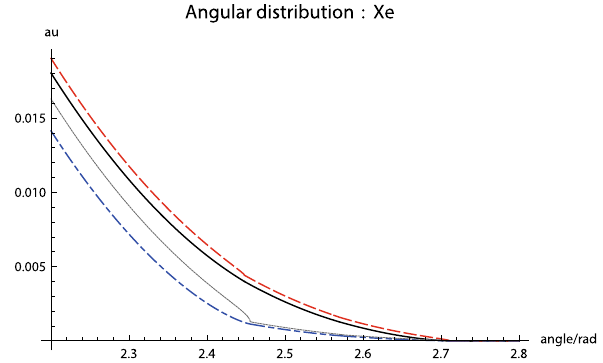
Fig. 10 Xe RANP angular distribution with r = 0 . 32304. Cases of NO Majorana of smallest neutrino mass 20 meV in solid black, NO Dirac of 20 meV in dotted black, IO Majorana 20 meV in dashed red, and IO Dirac 20 meV in dash-dotted blue. The absolute rate is obtained by multiplying a factor 0 . 12s − 1 assuming n 3 V η = ( 10 17 ) 3 cm −